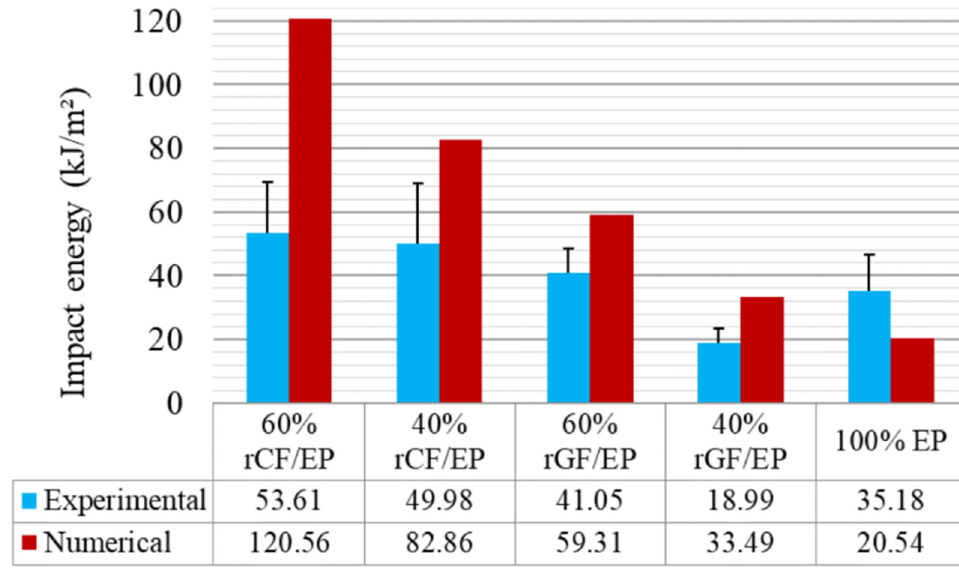
Figure 14. Measured impact strength of the composites experimental vs. numerical.